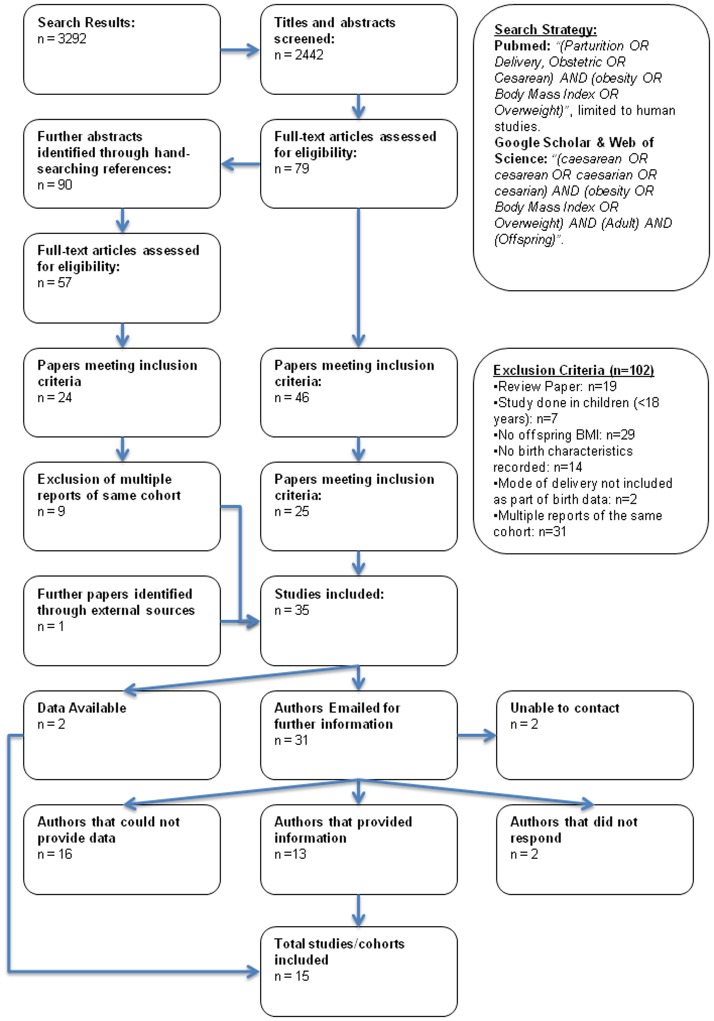
Flow chart of the search strategy used in the review.The relevant number of papers at each point is given.